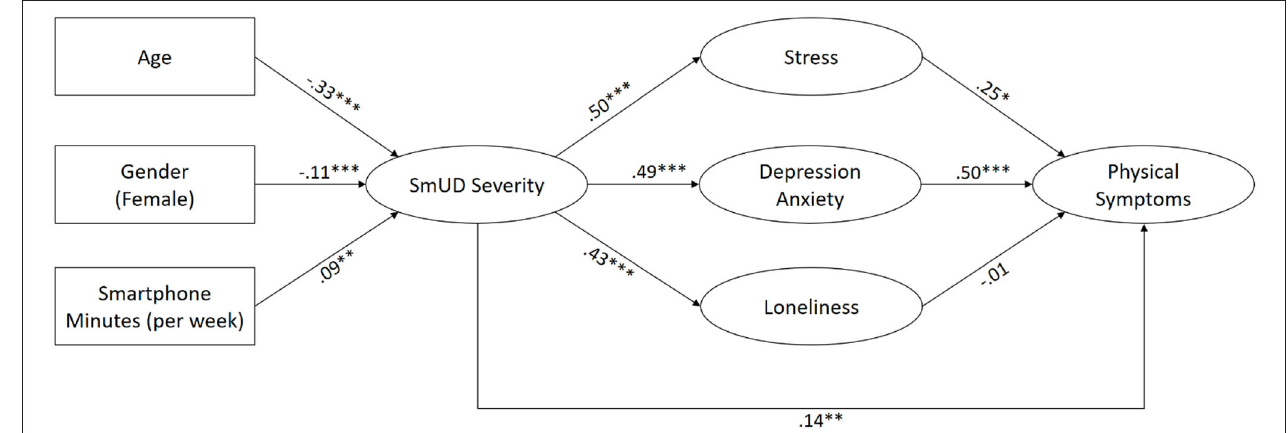
FIGURE 2 | Estimated structural model labeled with standardized regression coefficients. *** p < 0.001, ** p < 0.01, * p < 0.05. Direct paths from age, gender, and smartphone minutes to indicators of mental problems, and physical symptoms were estimated but are not shown for a clearer illustration (see Table 2 for a full matrix of all regression coefficients). SmUD, smartphone use disorder.